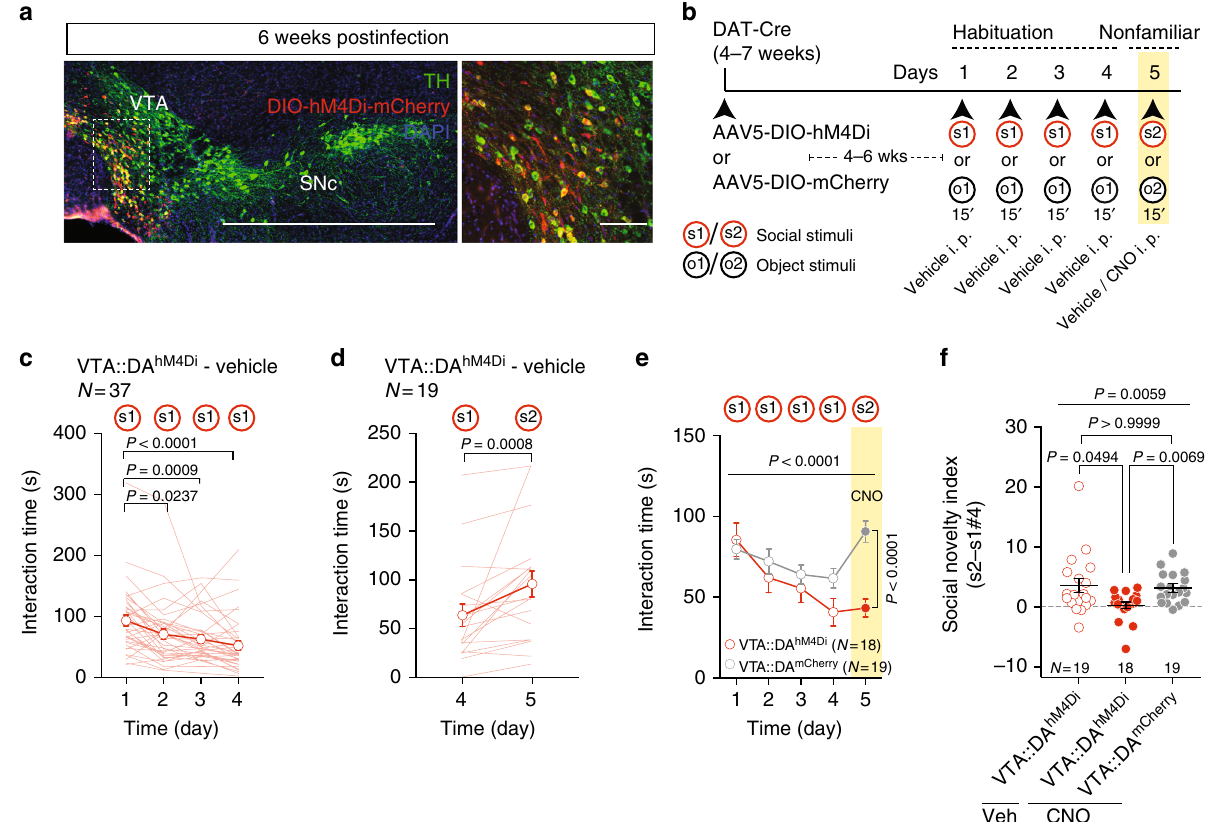
Fig. 1 VTA DA neuron excitability controls exploration of nonfamiliar conspeci fi c. a Representative images (low and high magni fi cation) of immuno- staining experiments against tyrosine hydroxylase (TH) enzyme (in green) performed on midbrain slices of DAT-Cre mice infected with AAV5-DIO- hM4Di-mCherry (red). Scale bar: 1 mm and 100 μ m. b Experimental time-course for the habituation/nonfamiliar exploration task. c Time course of time interaction for VTA::DA hM4Di mice treated with vehicle during habituation phase. Friedman test ( x 2 (4) = 32.94, P < 0.0001) followed by Dunn ’ s test for planned multiple comparisons. d Graph reporting the time interaction at day 4 with s1 and at day 5 with s2 for VTA::DA hM4Di mice treated with vehicle. Wilcoxon test ( W = 156). e Time interaction over days during the habituation/nonfamiliar exploration task (s1 and s2 are nonfamiliar conspeci fi c stimuli presented at day 1 – 4 and 5, respectively) for VTA::DA hM4Di and VTA::DA mCherry mice treated with CNO. Repeated measures (RM) two-way